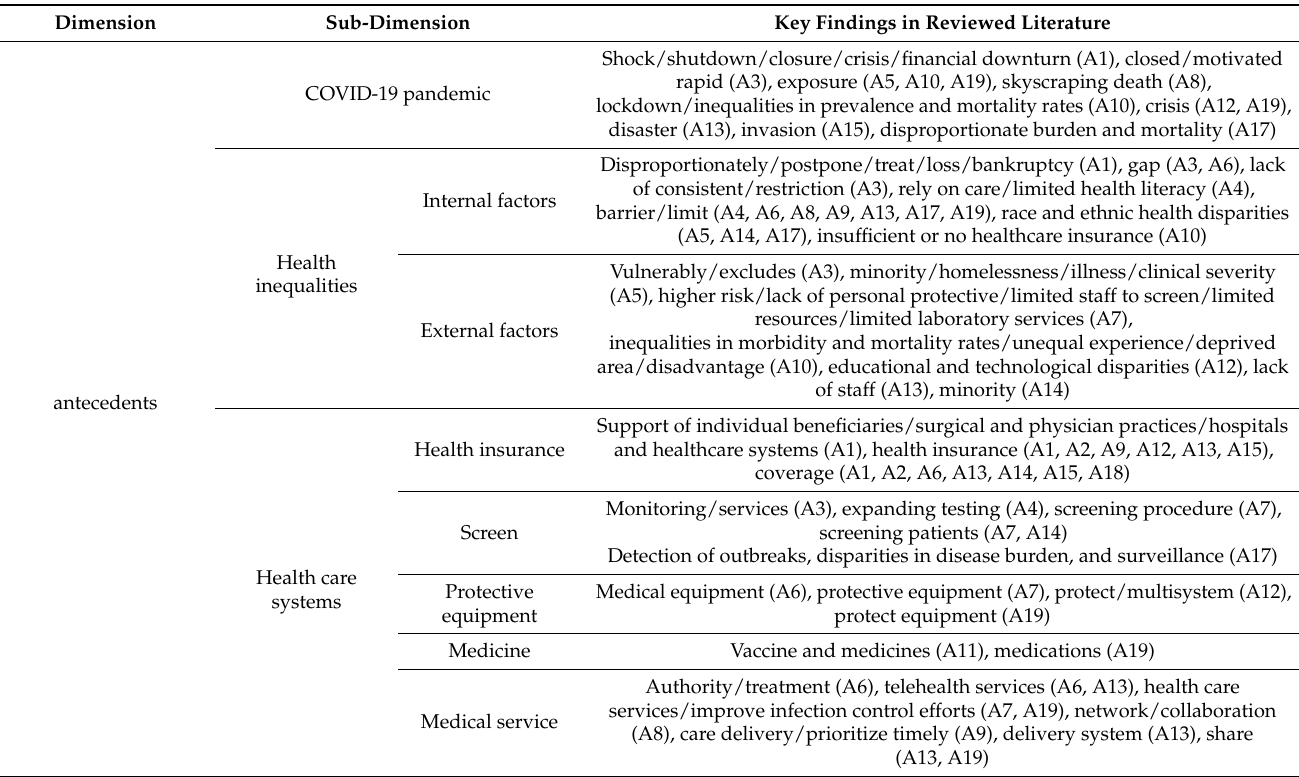
Table 2. Antecedents, attributes, and consequences of a healthcare safety